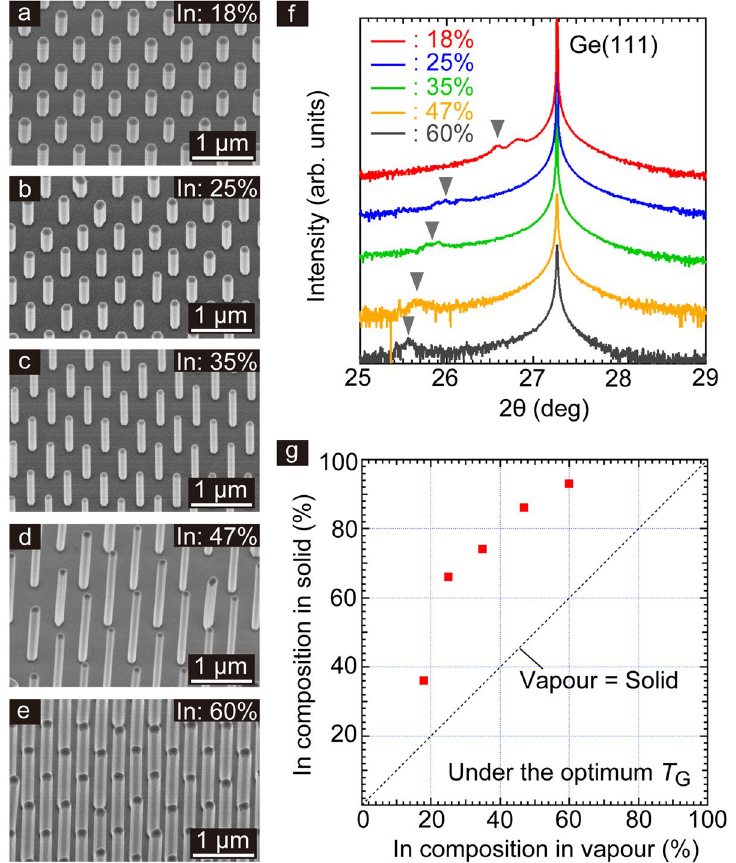
Figure 2. Direct integration of vertical InxGa1 − xAs NWs on Ge(111). 30°-tilted SEM images showing InGaAs NWs on Ge that were grown with various In compositions in vapour phase ( a ) 18%, ( b ) 25%, ( c ) 35%, ( d ) 47%, and ( e ) 60%. The NWs were grown at T G . ( f ) XRD spectra of InGaAs NWs on Ge in ( a – e ). ( g ) In composition in the solid phase of InGaAs NWs as estimated from the ( f ). The dashed line shows that the In composition in the vapour phase is equal to that in the solid